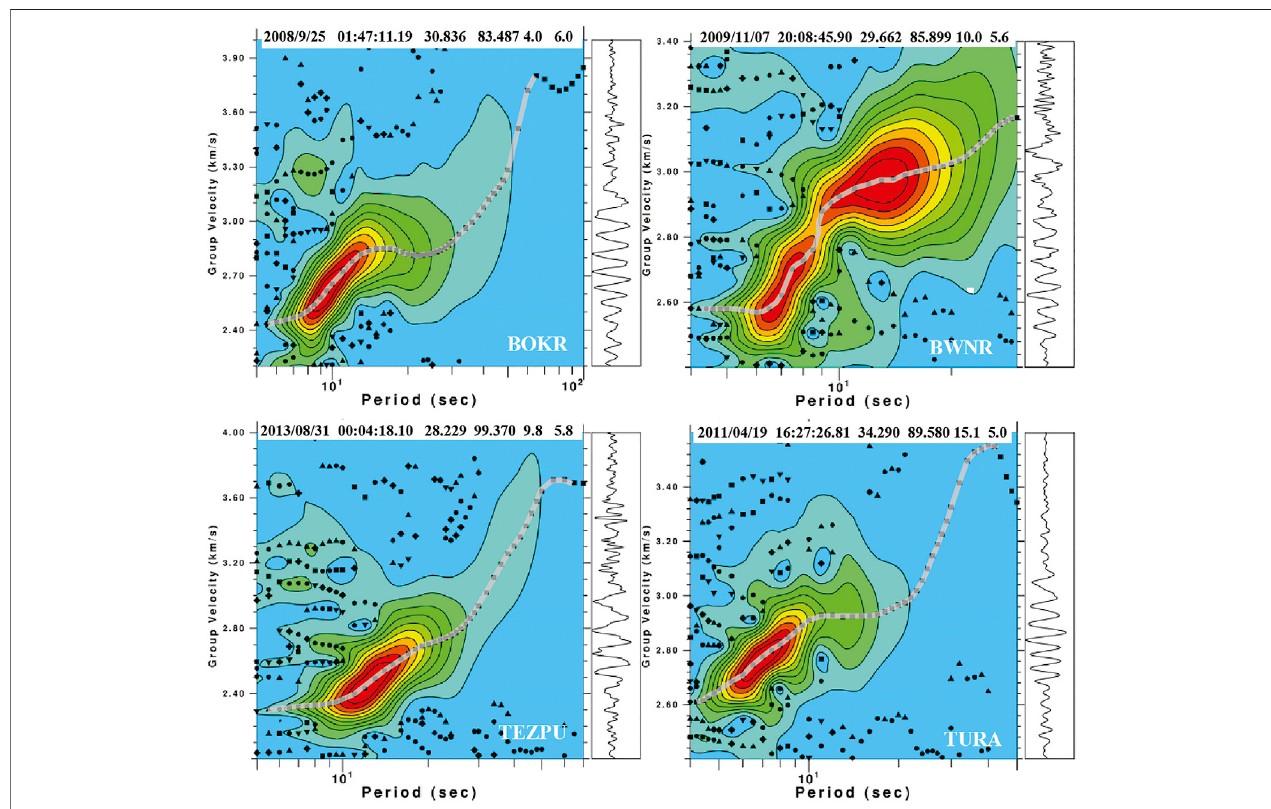
FIGURE 2 | Examples of dispersion curves obtained at four stations. Earthquake source parameters and the recording station names are mentioned on the dispersioncurveplot.Therangeofthedataofthedispersioncurveusedforfurtheranalysisisshownwithagray-colorcurve.Thecolorinaparticularcontourde fi nesthe energy with blue representing minimum energy and its energy increasing trend from blue to cyan to green to yellow to red. Raw waveform is given in the right-hand rectangular block.